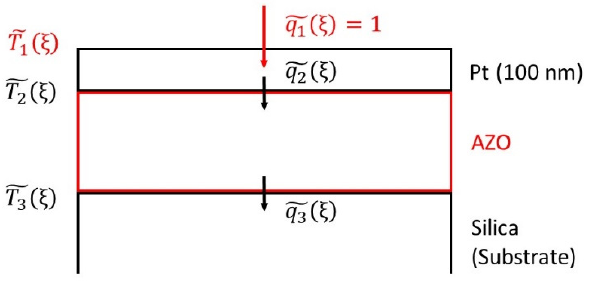
Figure A2. Diagram of the applied model.